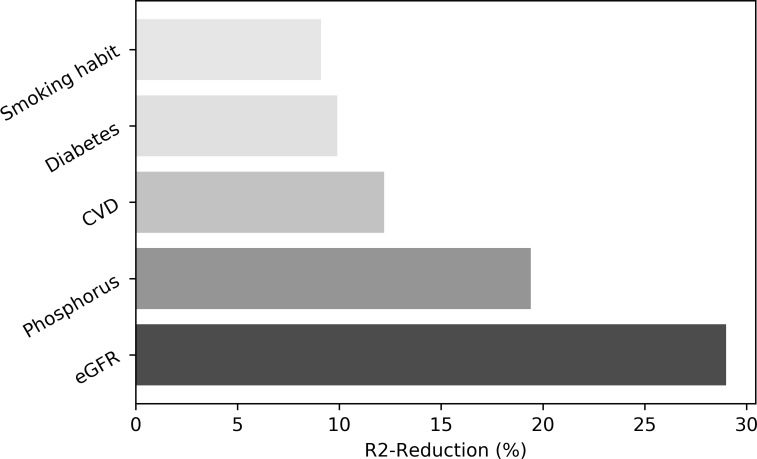
Individual contribution (expressed as %) of covariates included in Model 2 to the overall model fit according to R2 reduction analysis.Grey tones are graduated based on the amount of contribution of each variable. eGFR, estimated Glomerular Filtration Rate; CVD, cardiovascular disease.